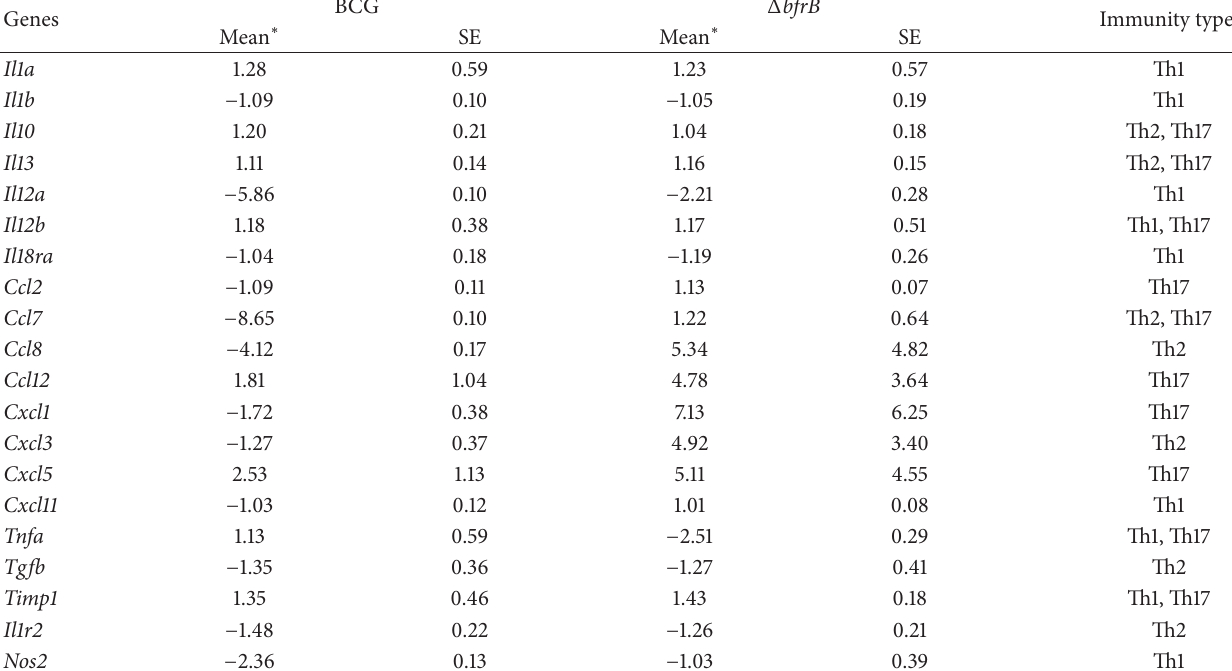
Table 2: Expression of selected immunity related genes in vaccinated